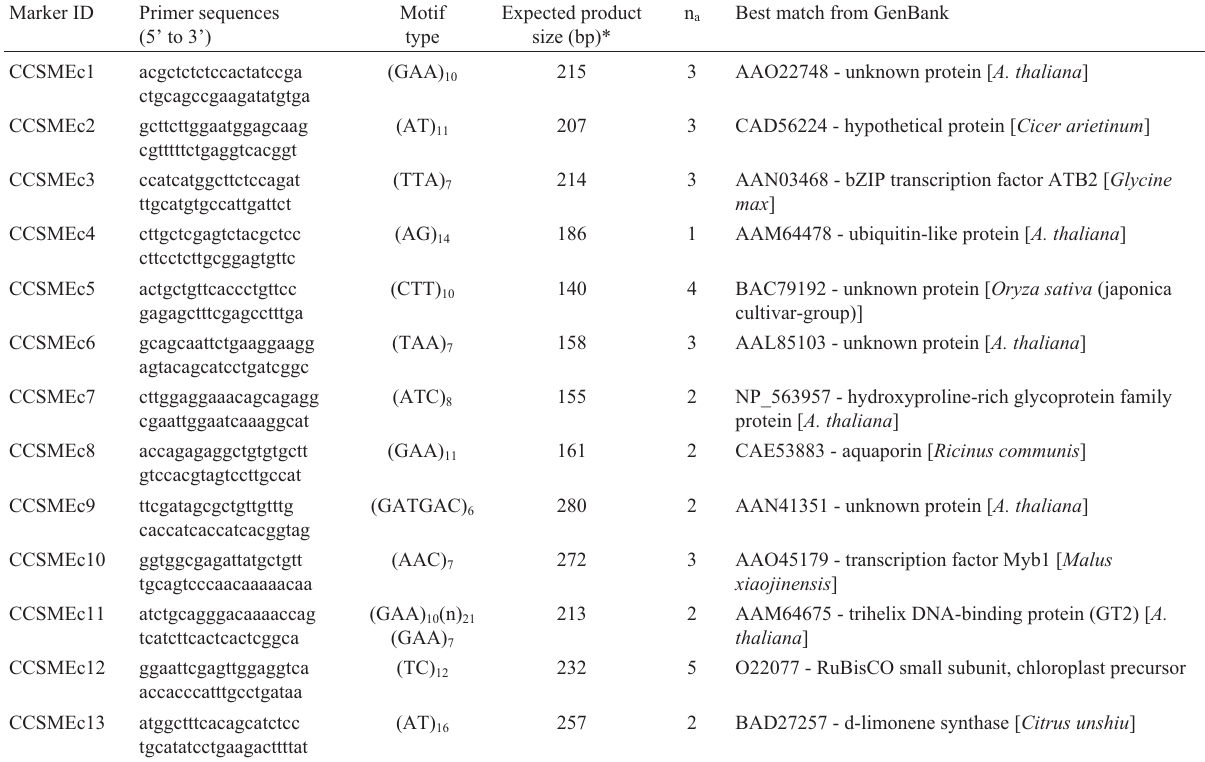
Table 4 - Description of 68 ESTs-SSRs from the CitEST